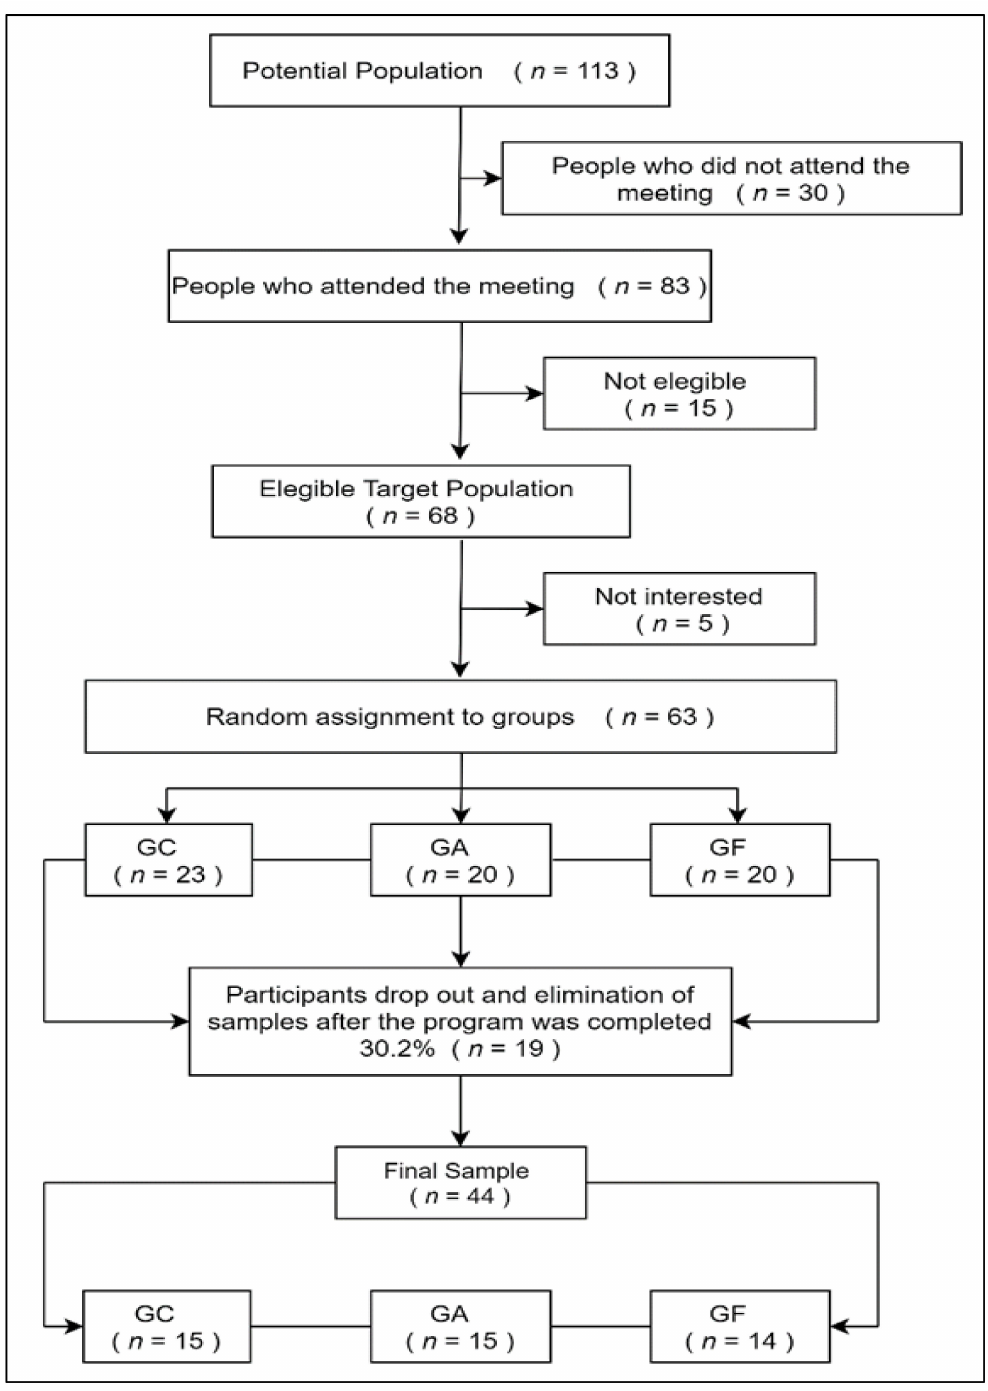
Figure 1. Sample recruitment scheme. Control Group GC: the aerobic training group GA: the resistance training group